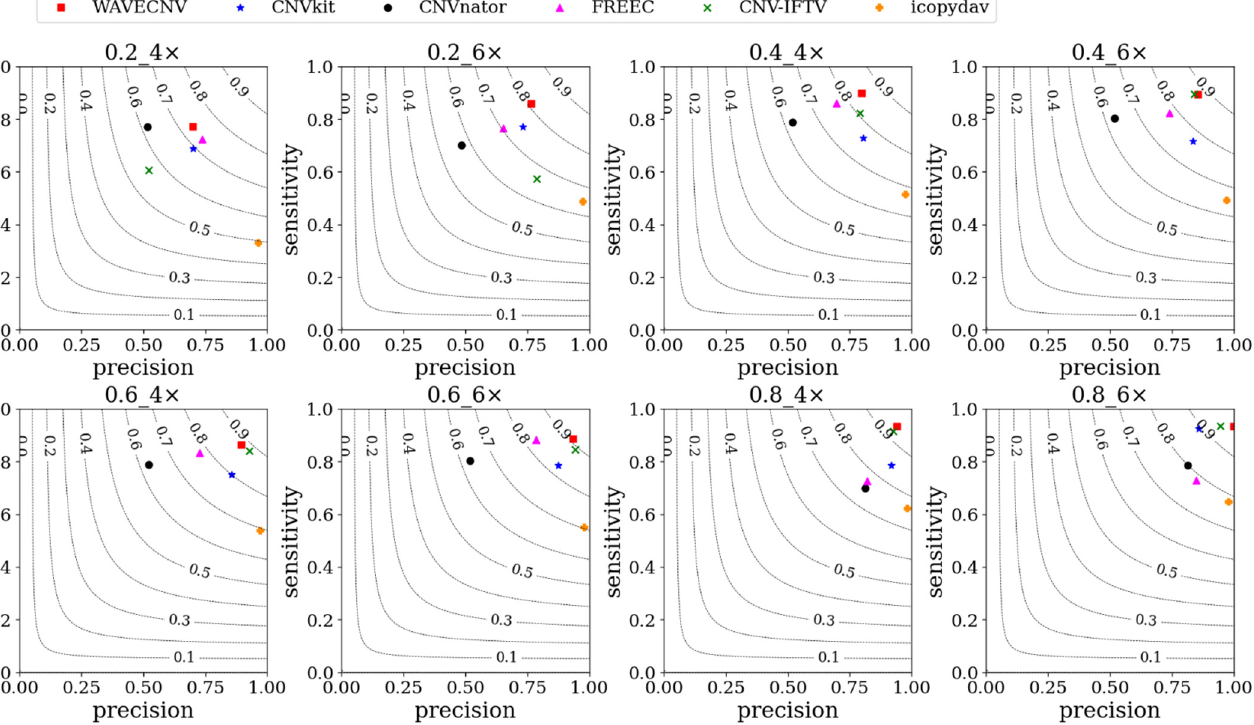
Figure 3. The precision, sensitivity, and F1 scores of the six methods are compared in the simula- tion data with different coverage and purity. The dotted line in the figure represents the contour line of the F1 score, the decimal of the title in the figure represents the tumor purity, and 4× and 6× represent 4 or 6 times the coverage. Among them, WAVECNV has the highest sensitivity and highest precision.